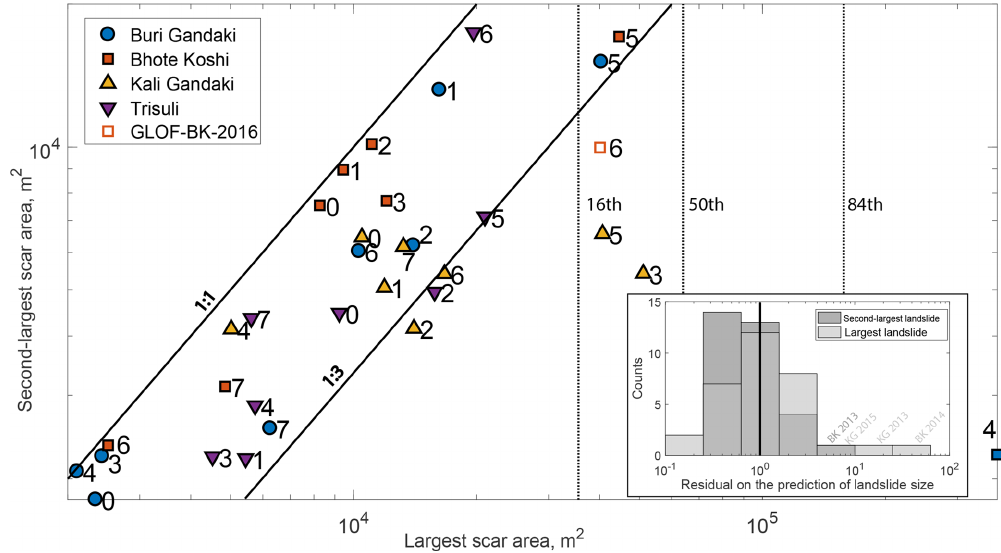
Figure 4. Area of the second-largest landslide scar plotted against the area of the largest landslide scar for monsoons in the period 2010– 2017 and four RapidEye mapping areas. The number associated with each symbol indicates the monsoon year relative to 2010. The 2016 Bhote Koshi inventory including the landslides attributed to the glacier lake outburst flood is shown as an open square; 1 : 1 and 1 : 3 lines are shown as solid black lines, while the three vertical dashed lines indicate the 16th, 50th and 84th percentiles of the landslide scar area from the 46-year long inventory of landslides with a whole area >0.08km 2 . The largest landslides in 2013 KG, 2014 BK and 2015 KG are 10–100 times larger than the rest of the landslide population triggered that year. Inset: histogram of the residual (ratio) between predicted (as a function of landslide number; see Malamud et al., 2004) and observed largest or second-largest landslide size. The black vertical line indicates correct prediction. For most years/catchments the predictions are within a factor of 3 of the observed largest size, except for BK 2014 and KG 2013 and 2015. When considering the second-largest landslides, these sub-inventories become